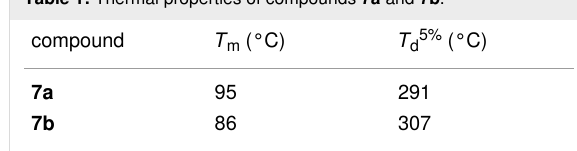
Table 1: Thermal properties of compounds 7a and 7b